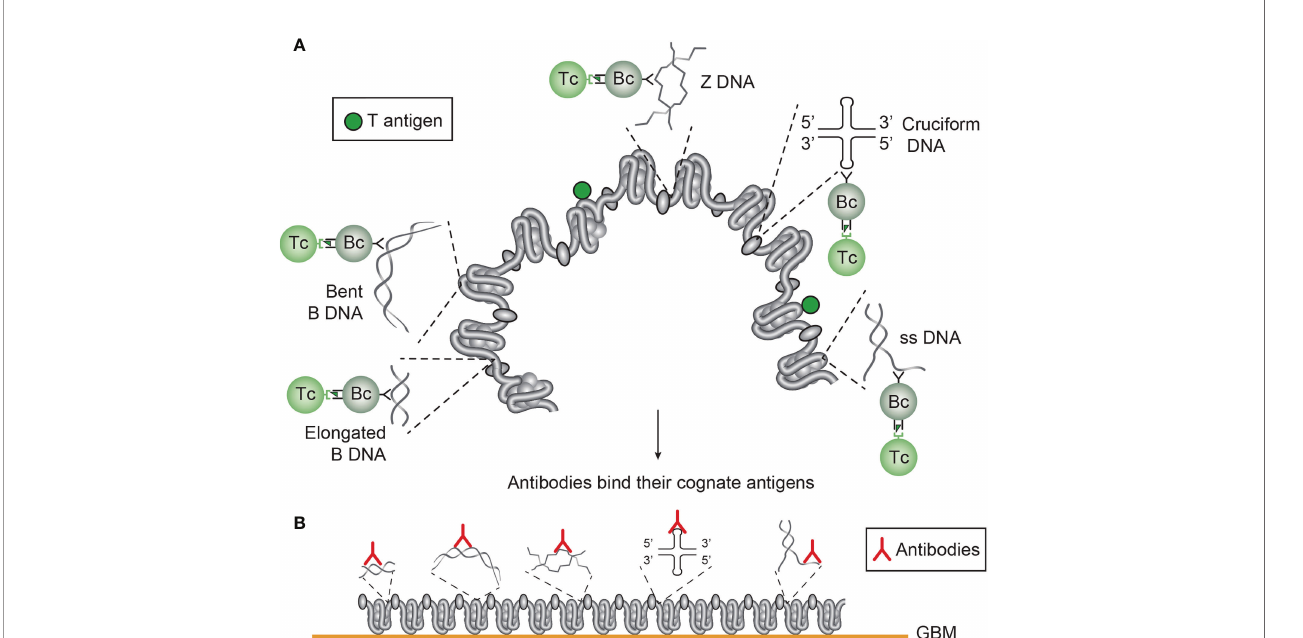
FIGURE 4 | Several unique DNA structures are accessible for B cells that present immunogenic peptides from non-self DNA-binding proteins (here exempli fi ed by polyomavirus T antigen). As indicated, all these exempli fi ed structures are solvent phase and accessible to B cells (A) . In this fi gure, polyomavirus T antigen is associated with chromatin in infected cells, and all DNA-speci fi c B cells that bind DNA/chromatin-T antigen complexes present T antigen peptides to responsive cognate T helper cells. The cognate interaction of DNA structure-speci fi c B cells and T antigen peptide-speci fi c T helper cells promote production of a repertoire of DNA structure-speci fi c antibodies. Since these antigens are accessible to B cell antigen receptors, circulating antibodies may have access to, and bind, the same specter of antigens in chromatin exposed in e.g. glomerulus basement membranes (B) . This model emerges from published experimental data on immunogenicity of the selected DNA structures as is discussed in the present text. This model is also valid in a true autoimmune context. Responsive histone-speci fi c T cells may fully substitute T antigen-speci fi c T cells. This will allow the same specter of DNA structure-speci fi c antibodies (see text for